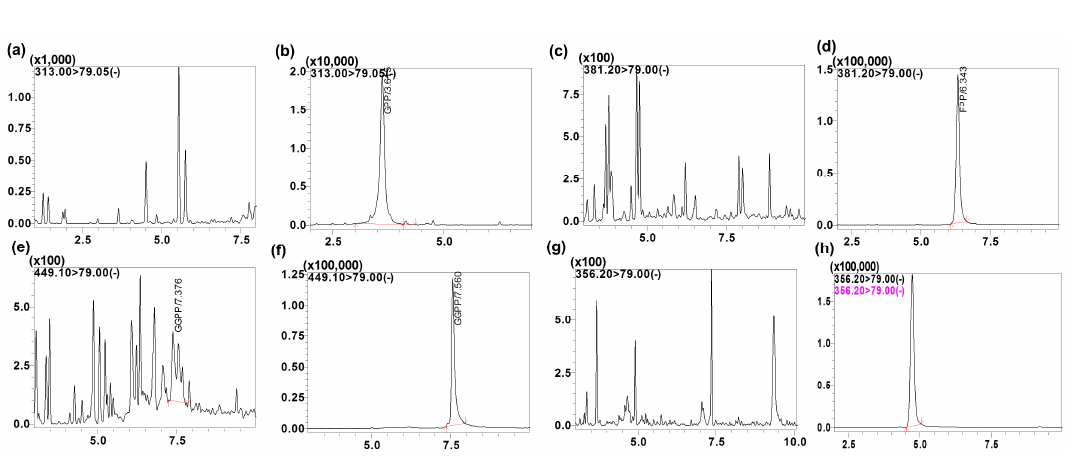
Figure 4. Representative MRM ion-chromatograms of ( a ) blank neat (GPP), ( b ) GPP spiked in neat solution (rt, 3.6 min, 10 ng/mL), ( c ) blank neat (FPP), ( d ) FPP spiked in neat solution (rt, 5.8 min, 10 ng/mL), ( e ) blank neat (GGPP), ( f ) GGPP spiked in neat solution (rt, 7.5 min, 10 ng/mL), ( g ) blank neat (RAM1147), ( h ) RAM1147 spiked in neat solution (rt, 4.7 min, 100 ng/mL).